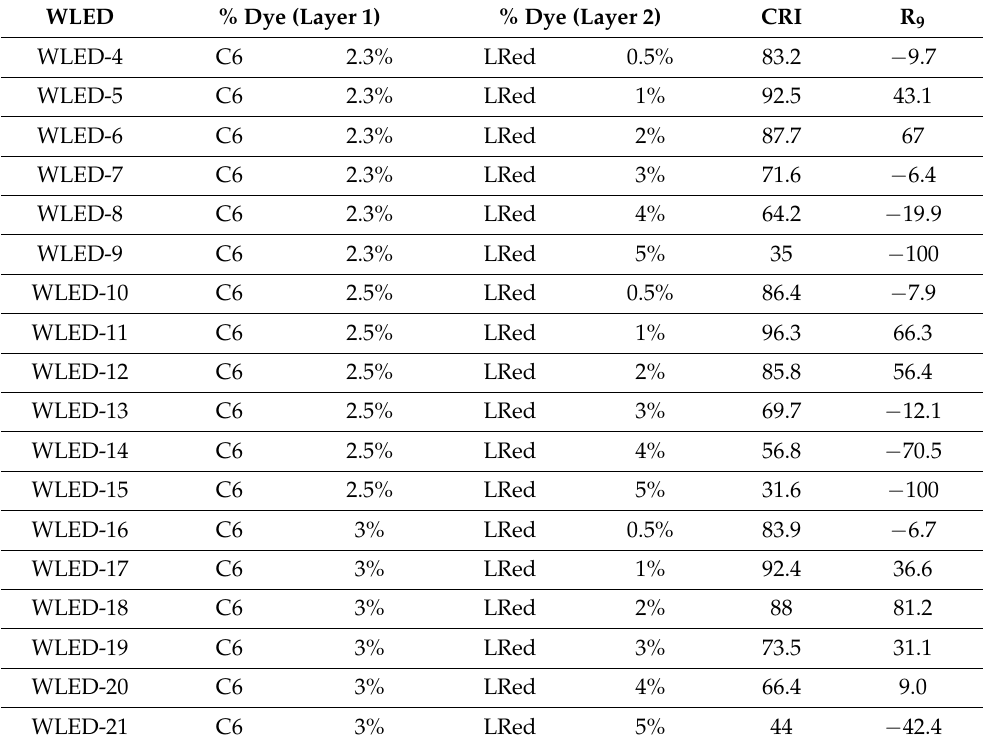
Figure 6. Spectral power distribution (SPD) chart ( a ) and CRI points ( b ) of WLED-2. Table 2 shows the different formulations of the developed spectral converters and the CRI and R 9 values of the resulting WLEDs. As shown in the table, there are several WLEDs with high values of CRI and high positive values of R 9 . Regarding the CRI, the best value (96.3) was achieved with WLED-11, providing a positive and good value of R 9 (66.3) at the same time. If we consider the R 9 parameter, the maximum value (81.2) was reached in the WLED-18, but the CRI value (88) was reduced by 8.3 units with respect to WLED-11. Therefore, unless we need a very specific application where deep reds are very impor- tant, we can conclude that WLED-11 provides better light quality than WLED-18. However, both provide excellent CRI and R 9 values. Table 2. Description of the WLEDs (4 to 21) and optical